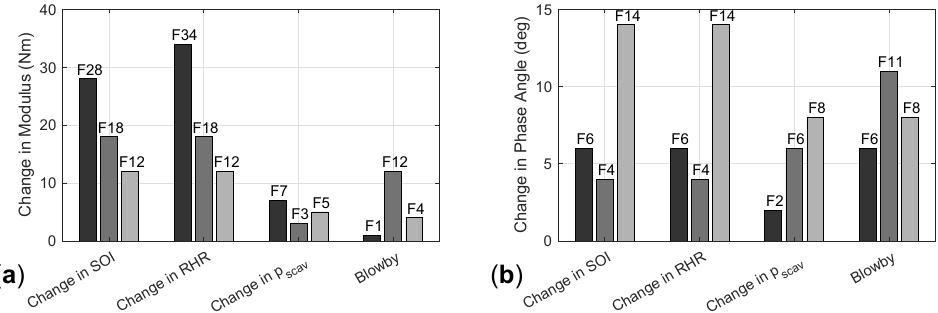
Figure 6. Change in the ( a ) modulus and ( b ) phase angle of the top three most affected engine harmonic frequencies from a malfunction of cylinder 2, at 100% load. Most affected frequencies are denoted with the letter F at the top of each bar.